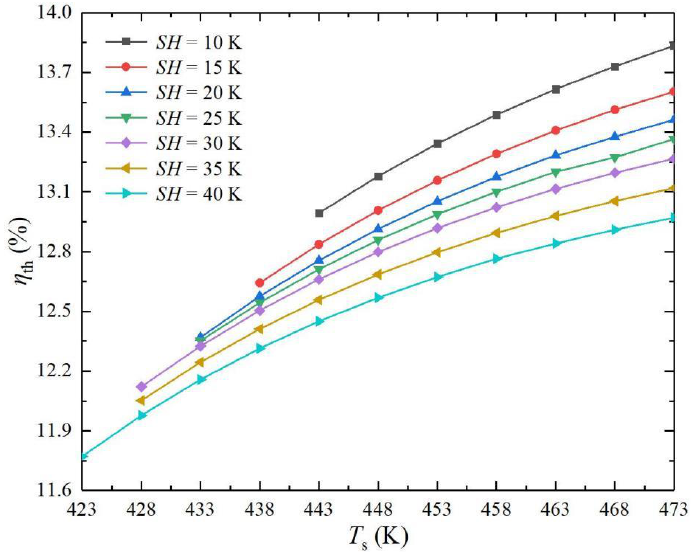
Figure 20. Relationship between the thermal efficiency and superheat degree.